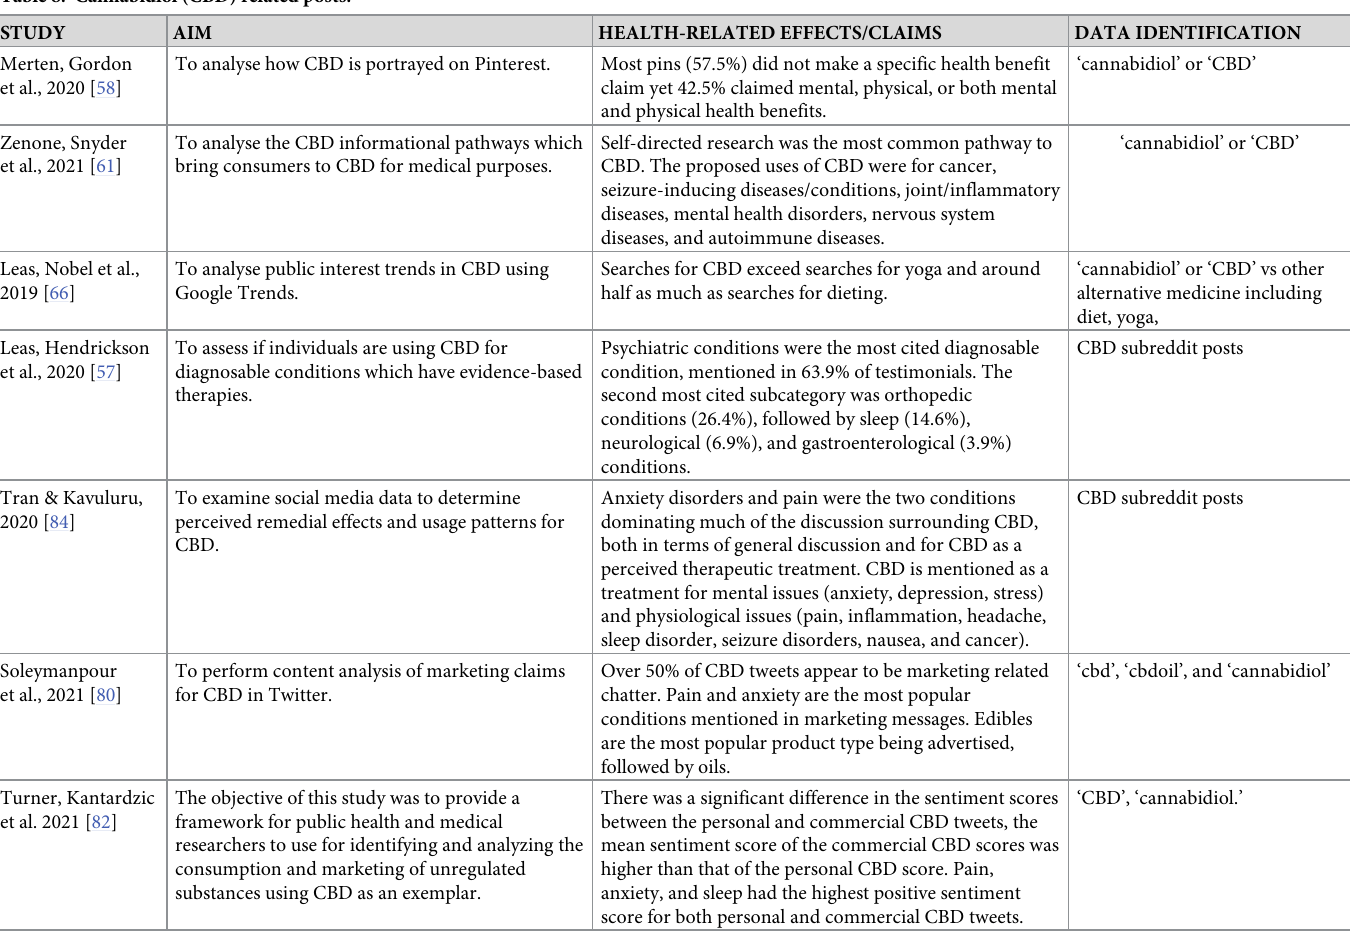
Table 8. Cannabidiol (CBD) related posts.